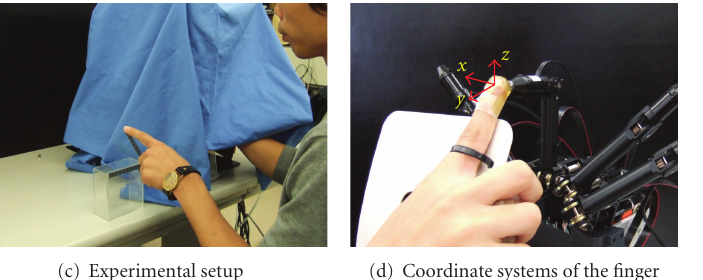
Figure 4: Measurement environment.